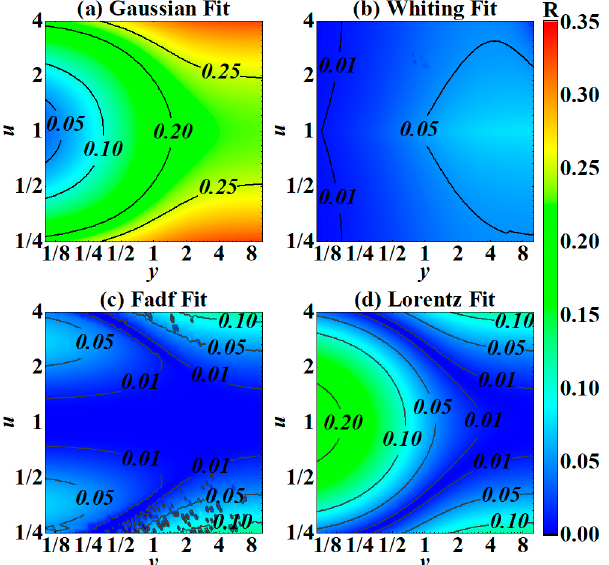
Figure 6. Distribution of the absolute value of the IA error calculated using the four fitting functions: ( a ) Gaussian Fit, ( b ) Whiting Fit, ( c ) Fadf Fit, ( d ) Lorentz Fit.